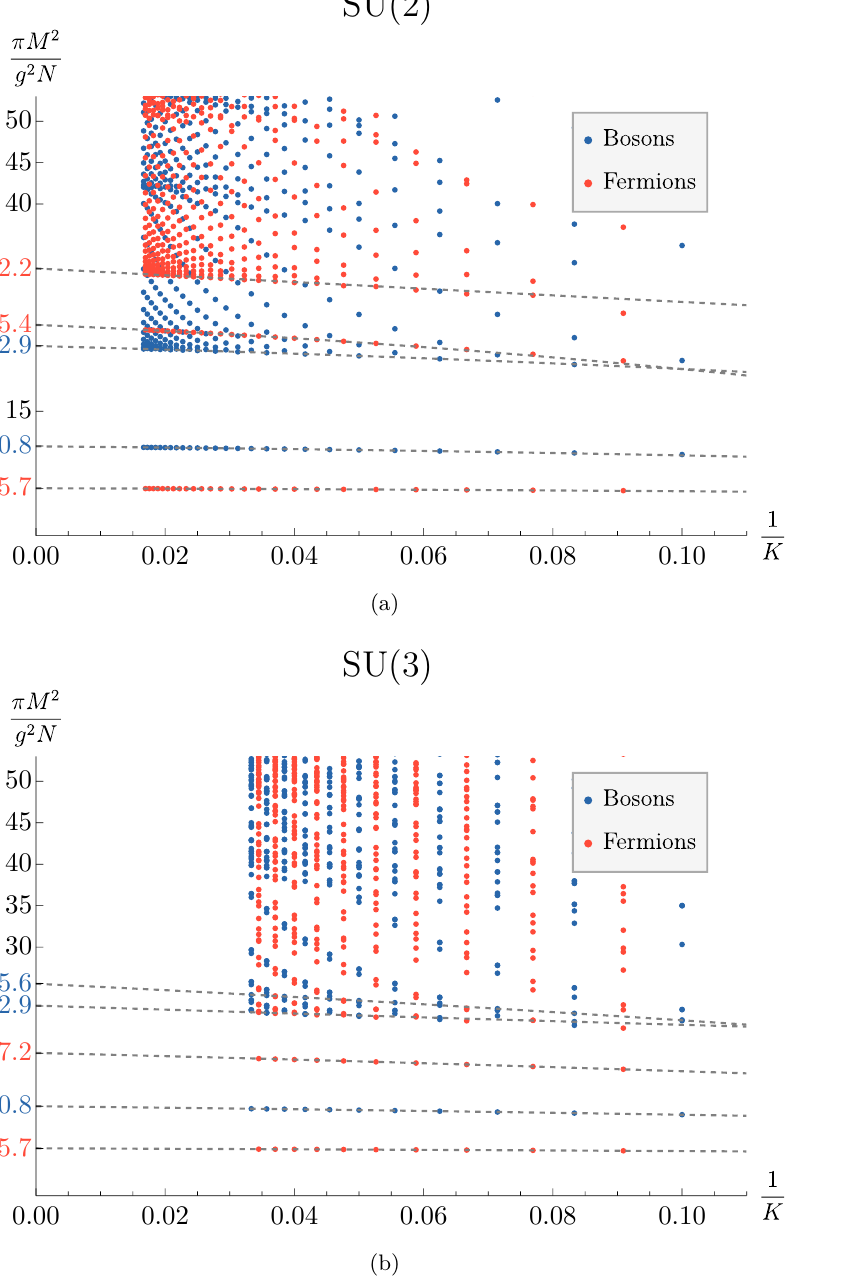
Figure 1 . The DLCQ spectra at y adj = 0 for SU(2) , SU(3) , SU(4) . We also exhibit the spectrum in the large N limit where we include the multi-trace states (the plot is therefore different from [10, 20, 22, 24] where only the single-trace states were exhibited). The spectrum of bound states below the continuum and the continuum thresholds are similar for N ≥ 3 , with fermion bound states at M 2 ≈ 5 . 7 g 2 N and M 2 ≈ 17 . 2 g 2 N and a boson bound state at M 2 ≈ 10 . 8 g 2 N , and continua for both π π π bosons and fermions beginning at M 2 ≈ 22 . 9 g 2 N . The SU(2) theory is distinct, lacking the fermion π at M 2 ≈ 17 . 2 g 2 N , having an extra fermion at M 2 ≈ 25 . 5 g 2 N , and with the fermion continuum π π threshold at M 2 ≈ 32 . 2 g 2 N π